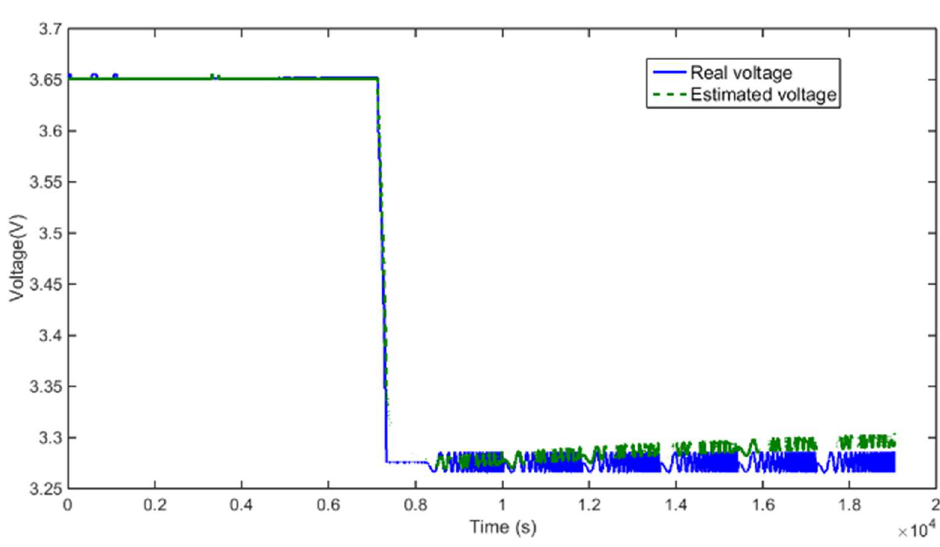
Figure 18. Comparison of real and estimated voltage of test 2 under dynamic condition.